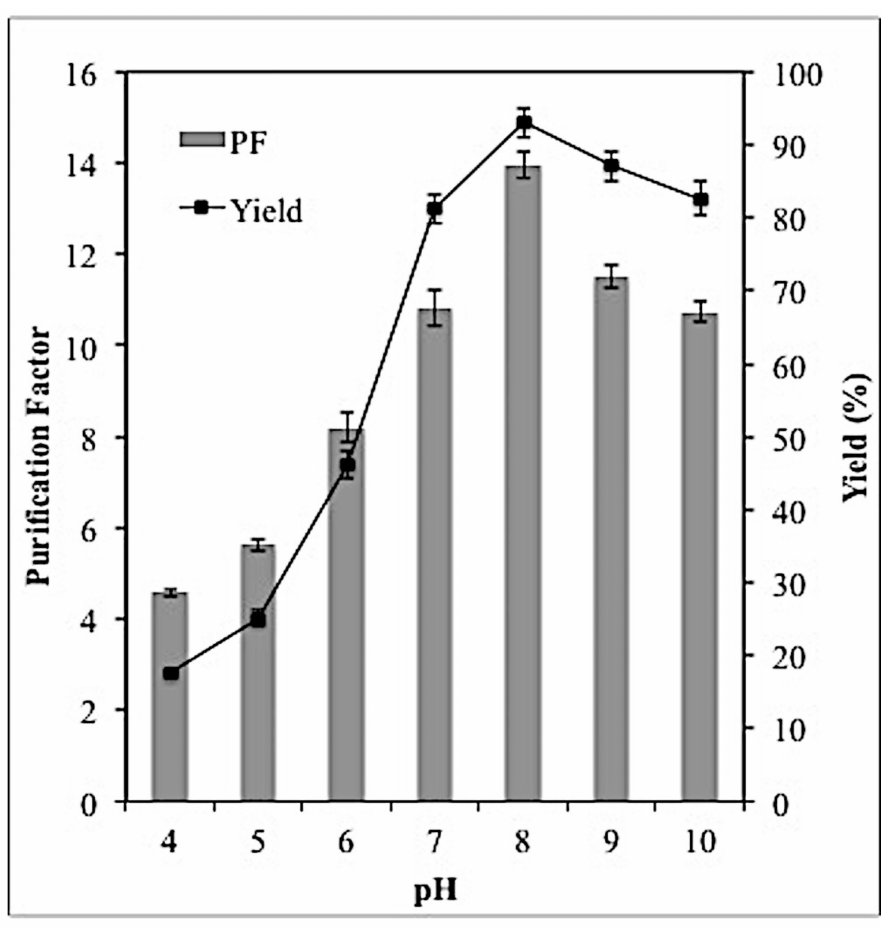
Figure 3. Effect of various pH on lipase partitioning in the top phase was investigated using 46.4% ( w / w ) TLL and 20% ( w / w ) crude load. All the assays were conducted in triplicate and the average values were